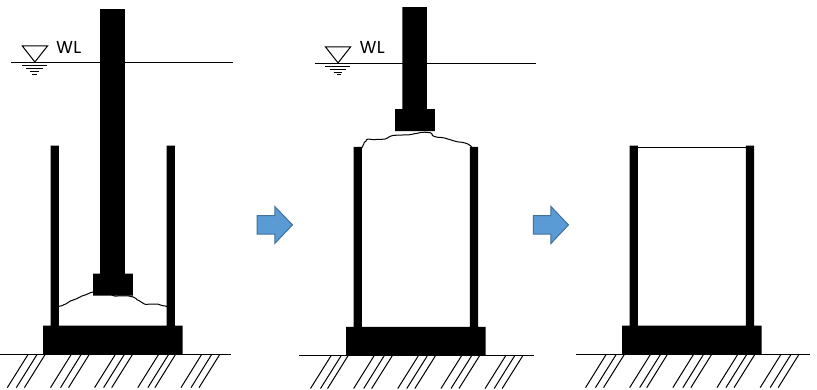
Figure 2. Manufacturing method of cylindrical specimen by direct casting of 3D-printed mortar.